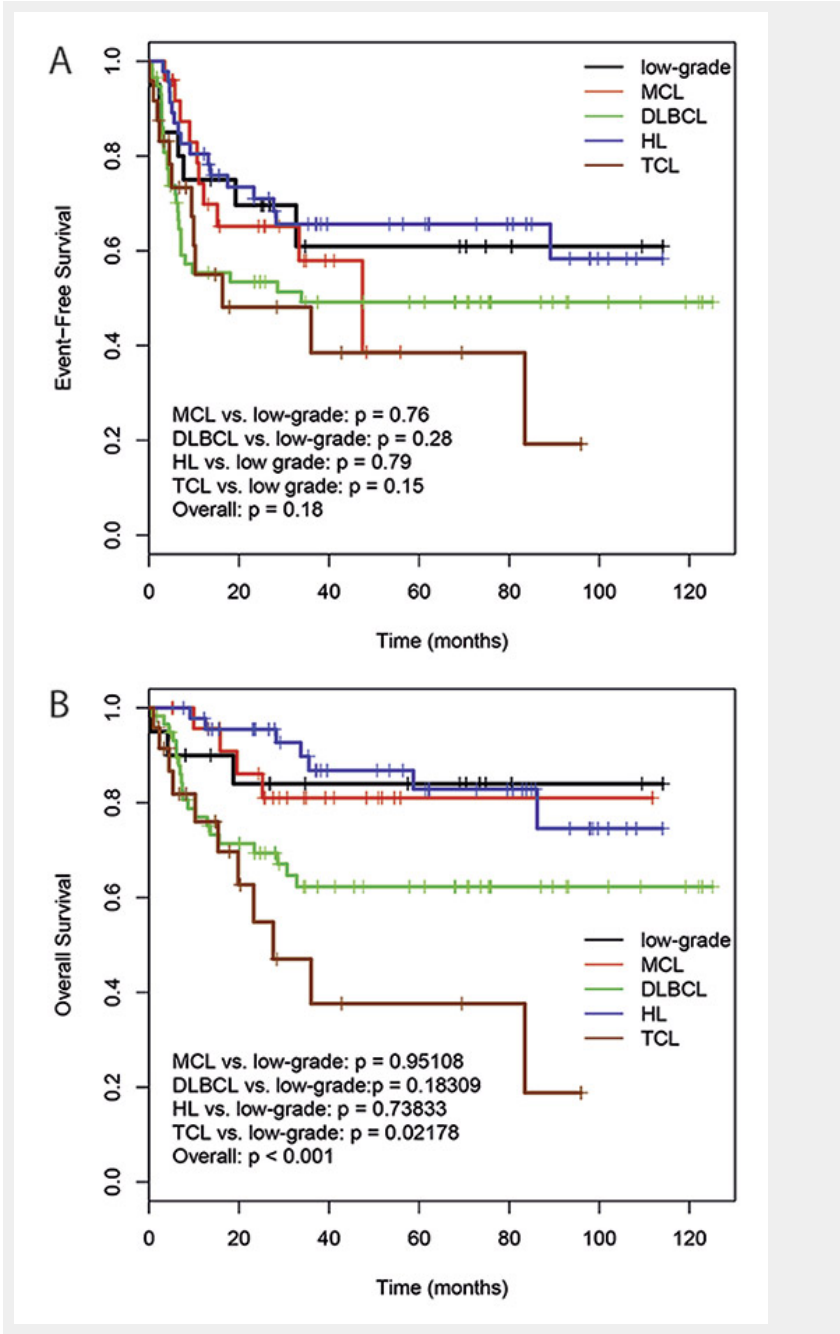
Figure 2 Event free survival (A) and overall survival (B) of the patients with respect to the different lymphoma subgroups. MCL, mantle cell lymphoma; DLBCL, diffuse large B-cell lymphoma; HL, Hodgkin’s lymphoma; TCL, T cell